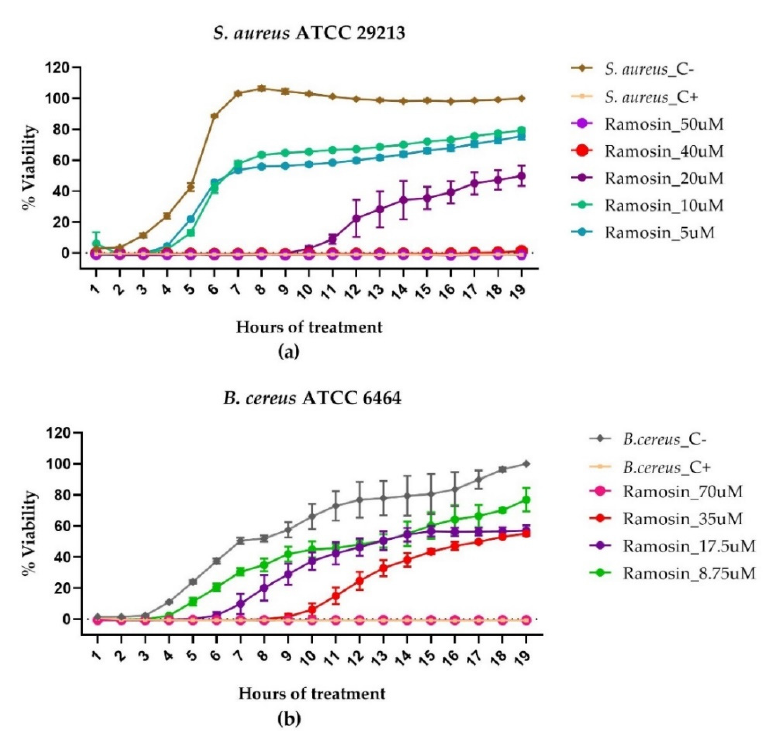
Figure 4. Growth inhibition kinetics of Gram-positive bacteria S. aureus and B. cereus treated with the Ramosin peptide from B. ramosi. Absorbance reading at 600 nm every hour of treatment. ( a ) S. aureus. ( b ) B. cereus. Three independent experiments were carried out for each bacterial strain. Data are presented as mean ± SD. C-: bacteria without treatment C+: bacteria treated with NaClO 0.012%.